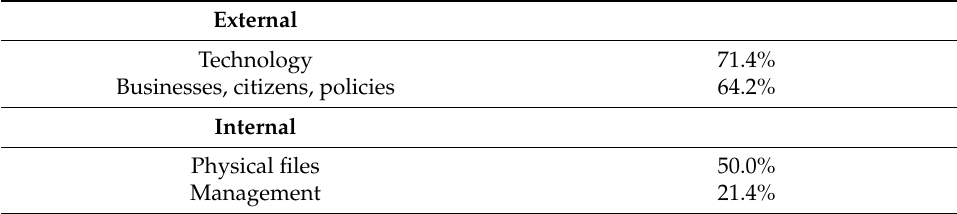
Table 1. Reasons for digital transformation.